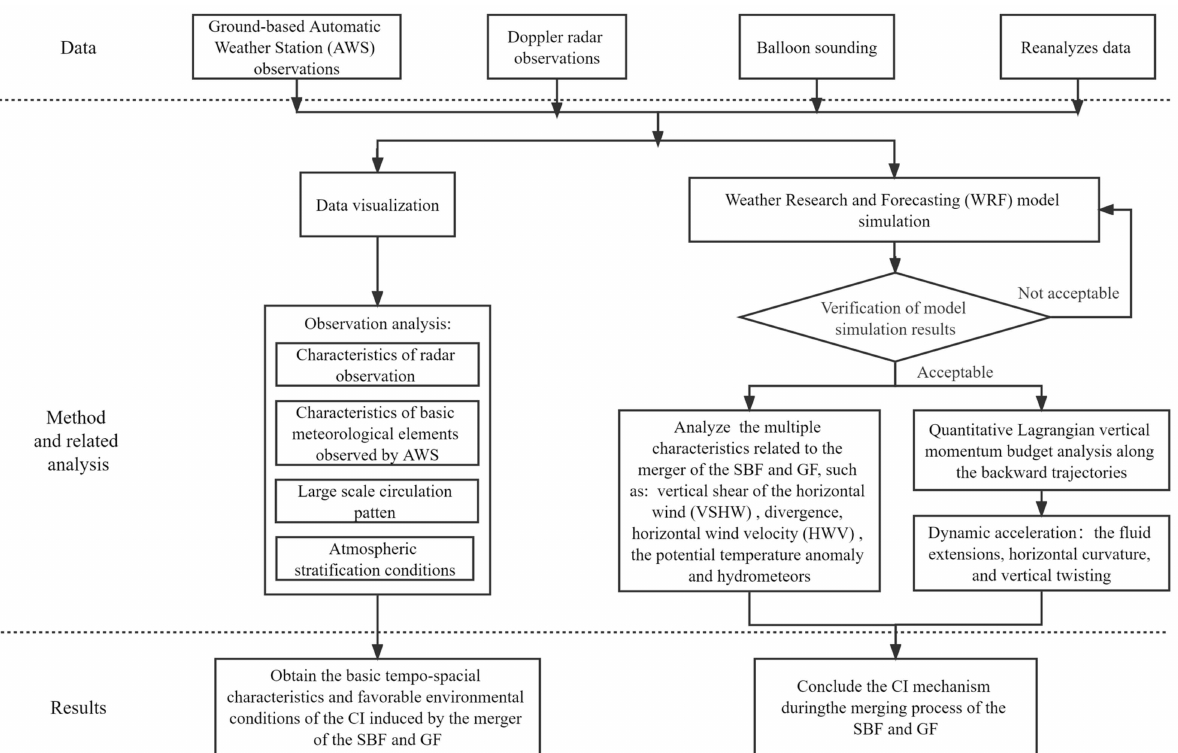
Figure 2. Flowchart of research approach and structure of present